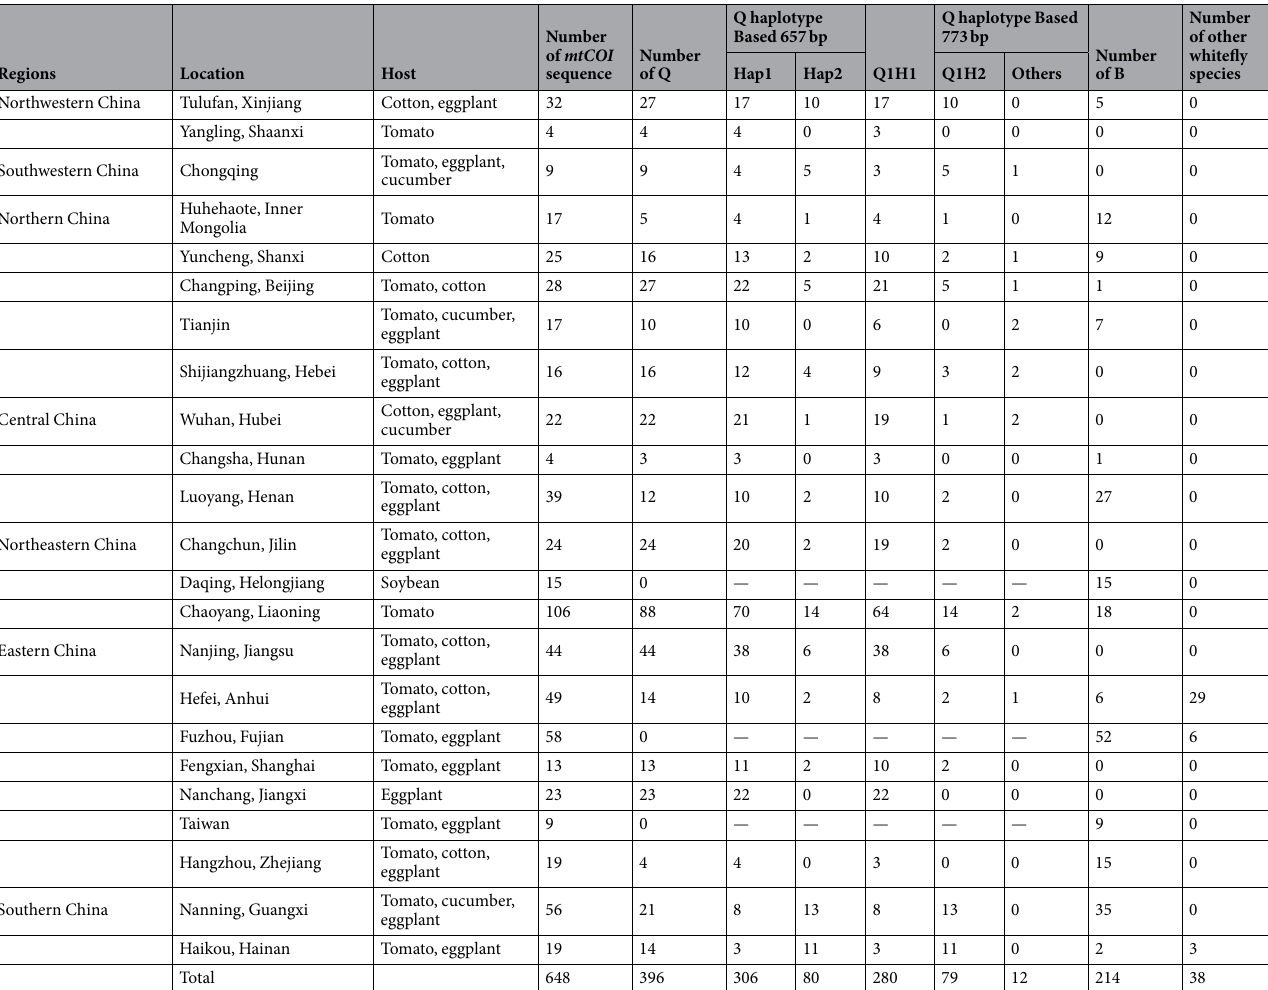
Table 1. Collections sampling localities and details for Bemisia tabaci in China in 2011. The haplotypes that were determined refers to haplotypes belonging to Q where there were at least two identical